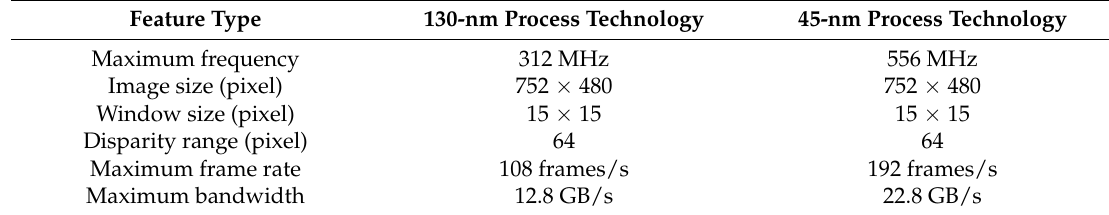
Figure 4. Pipelined hardware architecture of our stereo matching processor. Table 2. Main features of our stereo matching processors designed in 130- and 45-nm technologies.